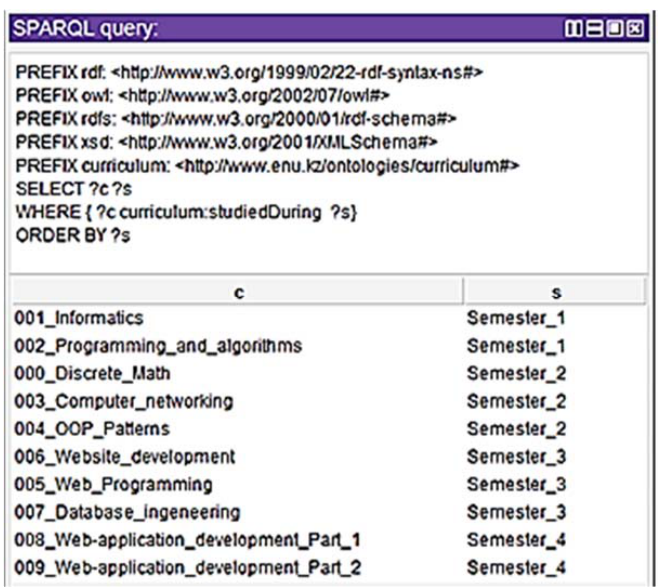
Figure 13. The list of courses in the curriculum with the indication of the